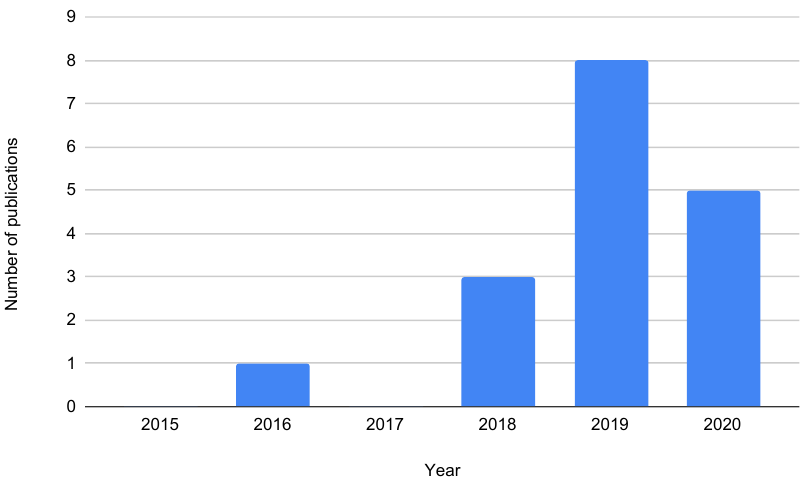
Figure 2. Number of considered publications obtained via Elsevier Scopus, Google Scholar, and Thomson Reuters Web-of-Sciences searches (plus the grey literature) on the applications of (D)RL in optimal MM by year in the 2015–2020